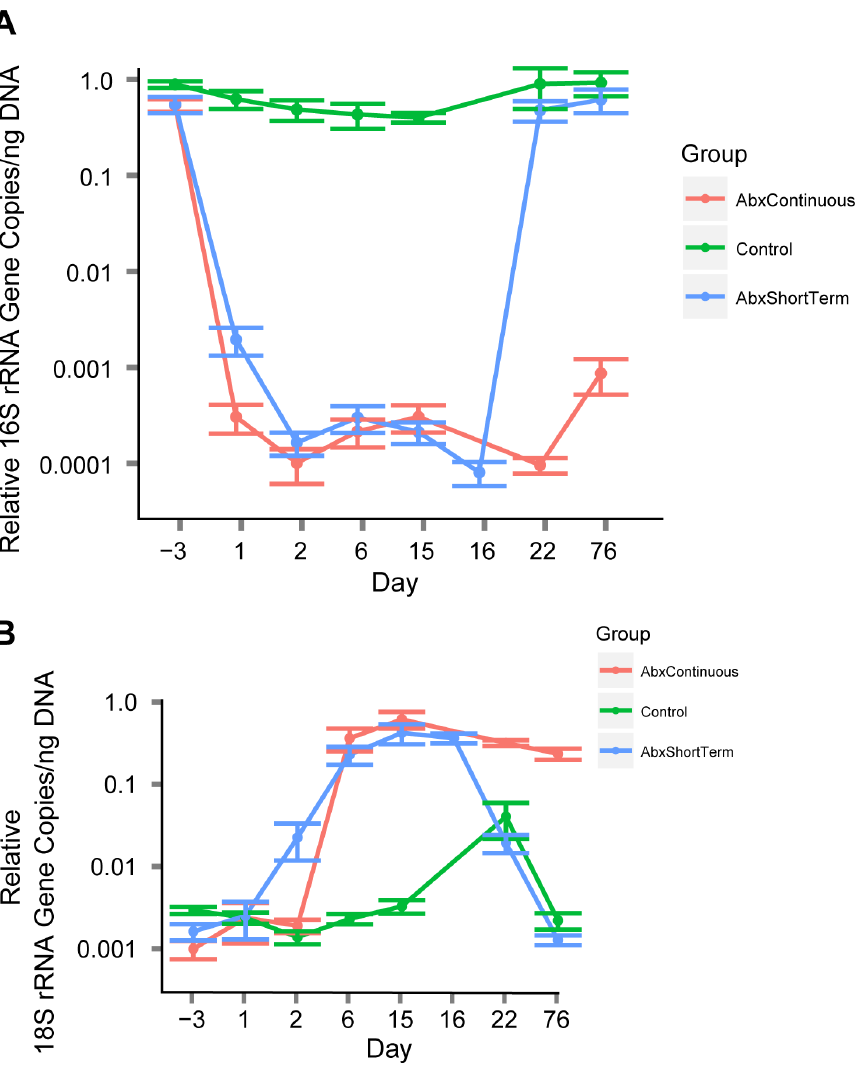
Figure 2. Relative microbial abundance inferred from QPCR. A) Longitudinal analysis of 16S rRNA gene copies per ng of stool DNA. The groups of mice tested are shown by the color code (key at right). Error bars indicate standard error. B) Longitudinal analysis of 18S rRNA gene copies per ng of stool DNA. The groups of mice tested are shown by the color code (key at right). Error bars indicate standard error. The amplicon used was designed to suppress amplification of DNA from mouse or food